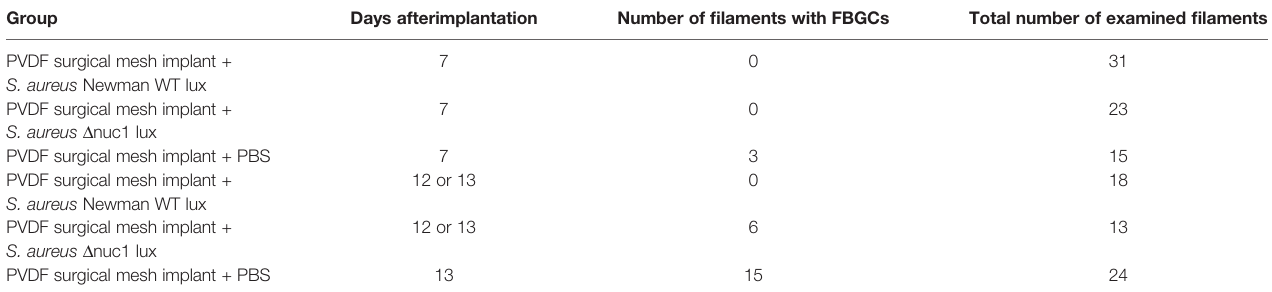
TABLE 1 | Appearance of foreign body giant cells (FBGCs) in the vicinity of the PVDF surgical mesh implant mesh implant. Group Days afterimplantation Number of fi laments with FBGCs Total number of examined fi